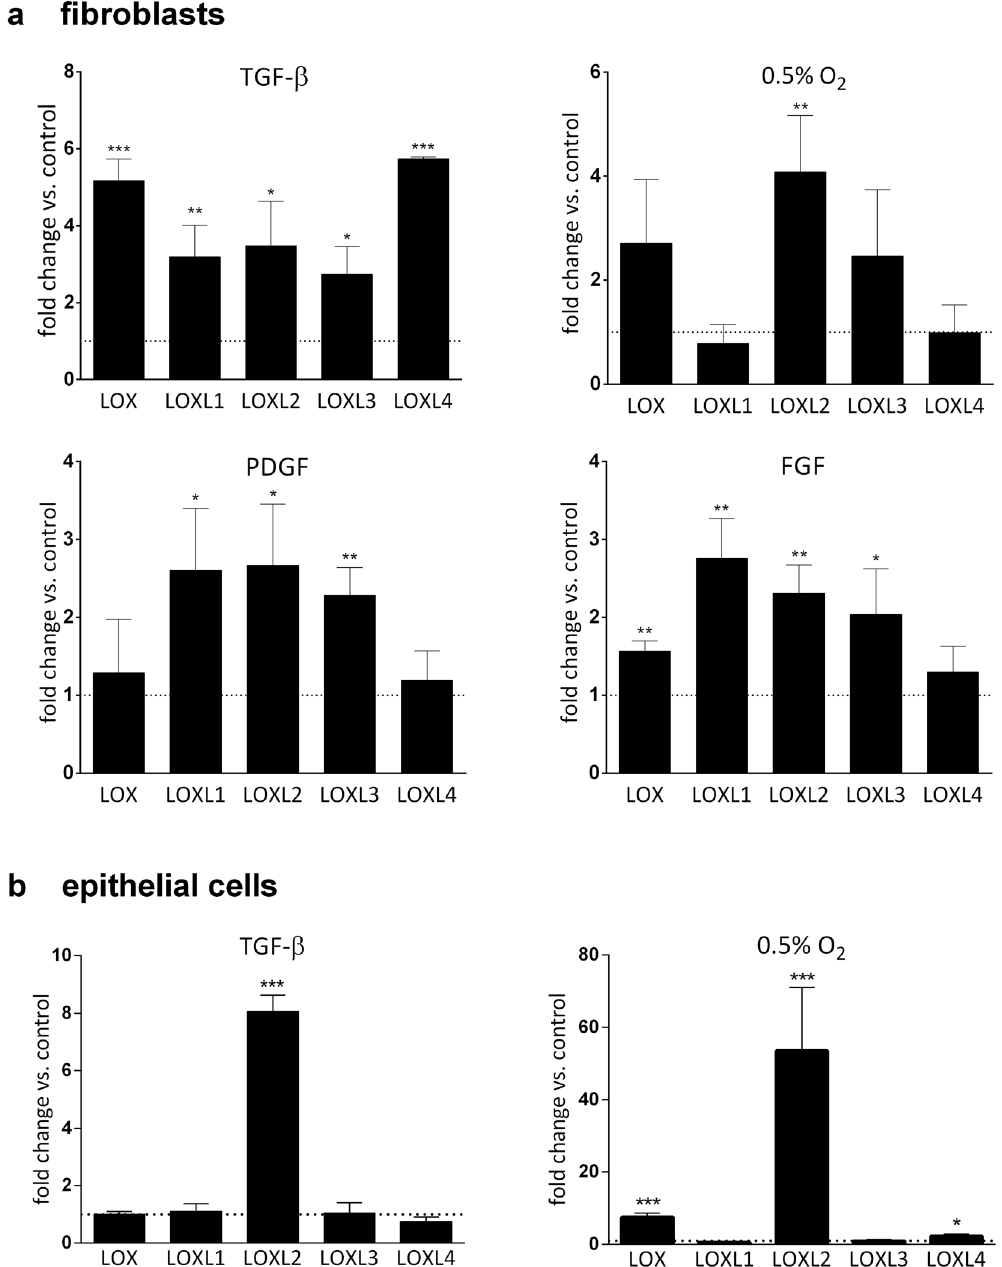
Figure 2. LOX/L gene expression level changes induced by various pro-fibrotic stimuli in primary human lung cells. ( a ) Primary human lung fibroblasts (NHLF) were treated with TGF- β 1 (5 ng/ml), FGF (20 ng/ ml) or PDGF (50 ng/ml) for 24 hours or kept under hypoxic conditions (0.5% O 2 ) for 24 h followed by RNA isolation and quantitative PCR for the members of the LOX/L family. Data was normalized to RNA polymerase 2 expression and depicted as fold change relative to respective control treatment. Data is shown as mean ± SD of 3–4 independent experiments. ( b ) Primary human bronchial epithelial cells (HBECs) were differentiated at the air liquid interface for 21 days followed by basal treatment with TGF- β 1 (5 ng/ml) for 48 h or kept under hypoxic conditions for 24 hours. RNA was isolated and quantitative PCR for the members of the LOX/L family was performed. Expression data was normalized to RNA polymerase 2 expression and control treatment and is depicted as mean ± SD of three experiments. * p < 0.05; ** p < 0.01; *** p < 0.001, relative to control